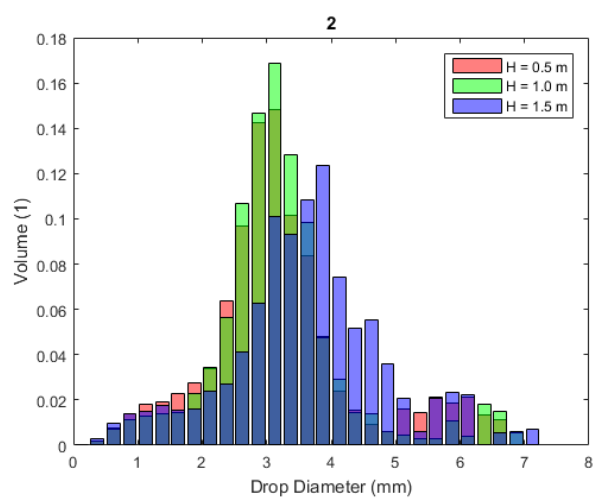
Fig. 10. Drop size histogram based on volume for the mean